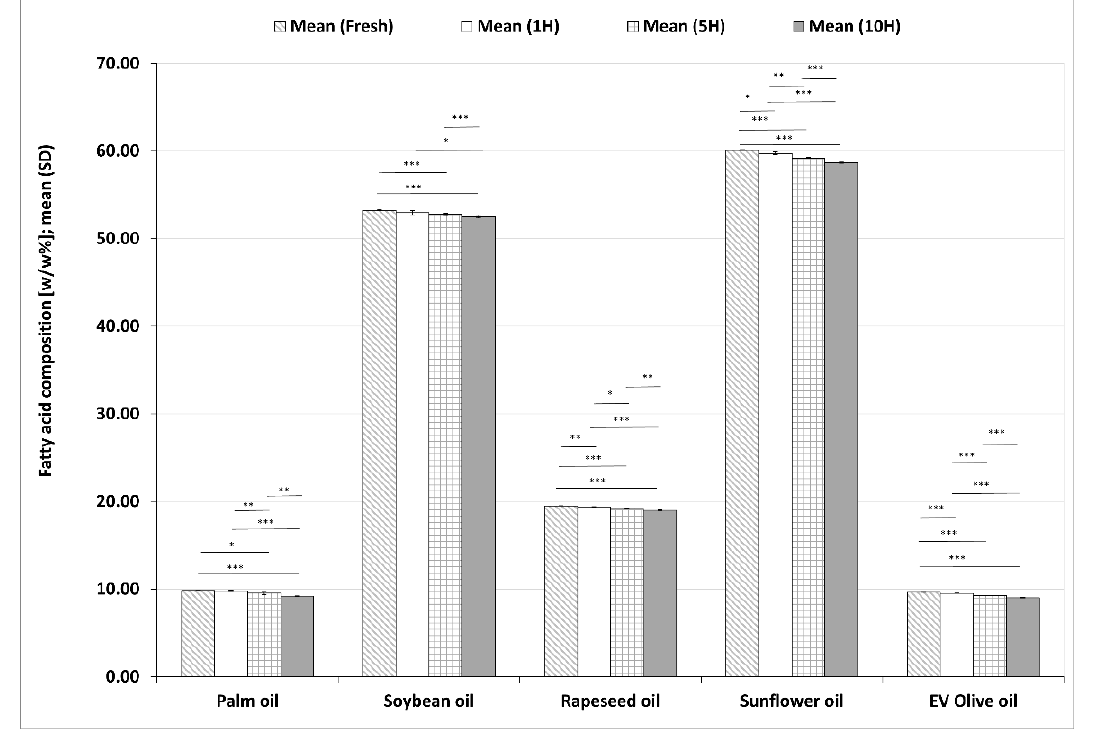
Figure 2. Changes in linoleic acid (LA) values in five different plant-based oils in fresh samples and after one (1H), five (5H) and ten heating sequences (10H). Each column shows the mean (SD) data of six different chromatograms. Asterisks denote statistically significant differences between the different time points in the same oil; *: 0.01 ≤ p < 0.05; **: 0.001 ≤ p < 0.01; ***: p < 0.001. EV olive oil: extra virgin olive oil.